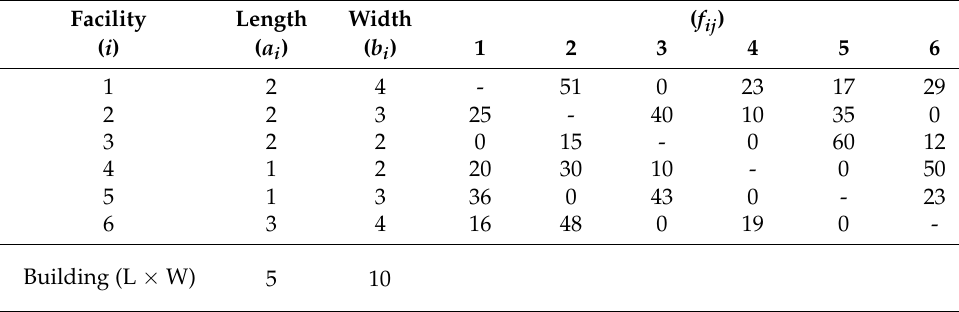
Table 1. Data for small UA-FLP instance.